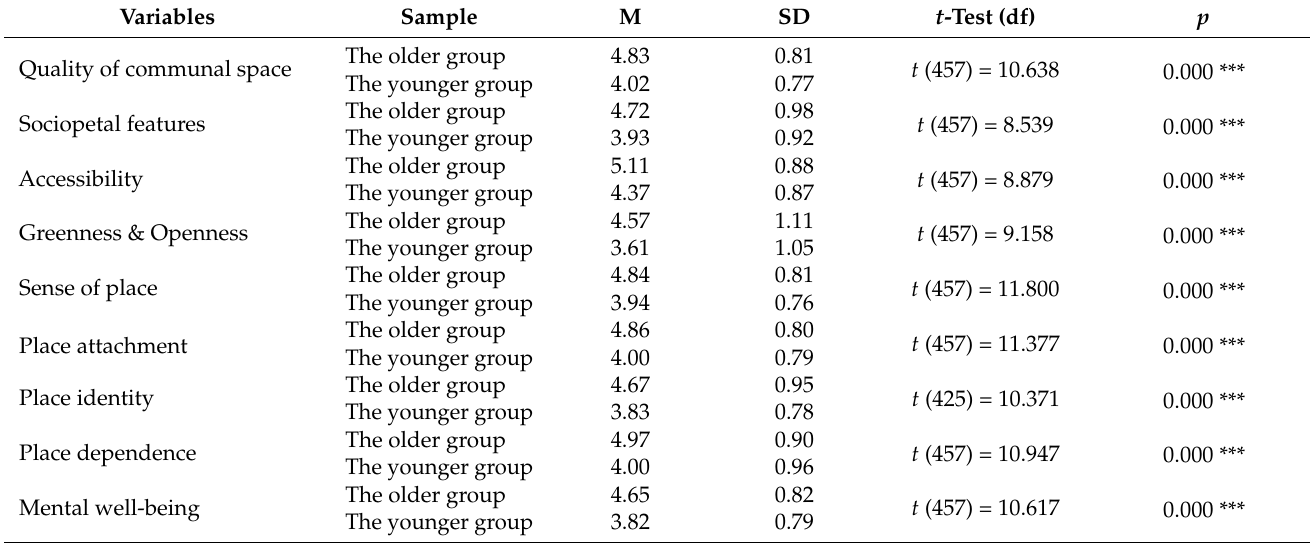
Table 4. Descriptive Statistics of HK samples (N young = 177, N old = 282).